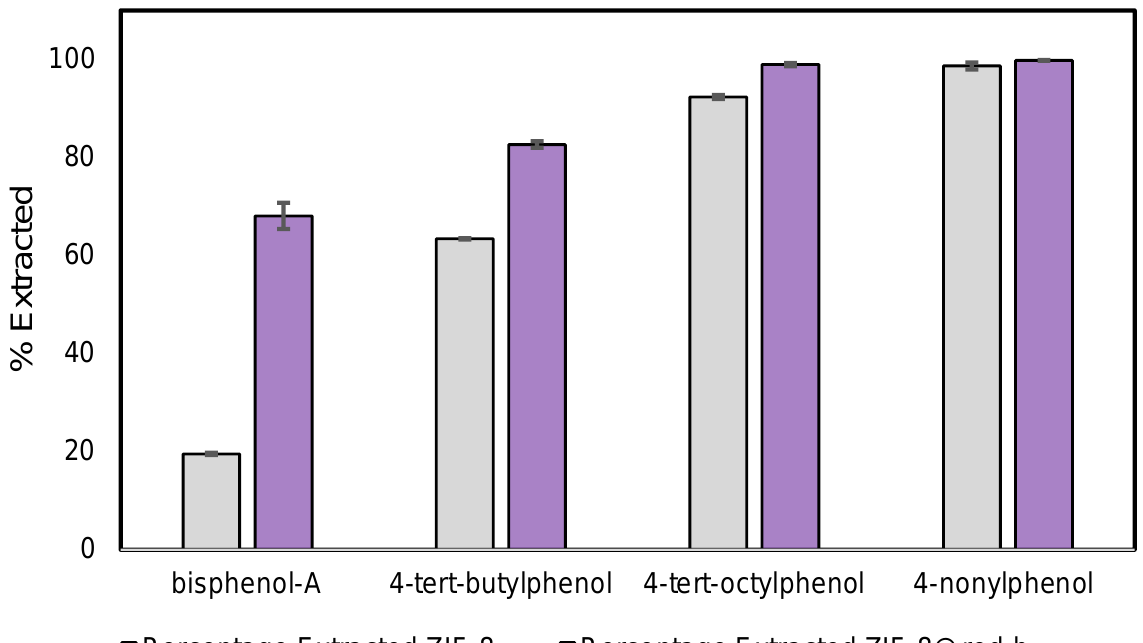
Figure 7. Performance of ZIF-8 and ZIF-8@RB for the extraction of phenols from water.